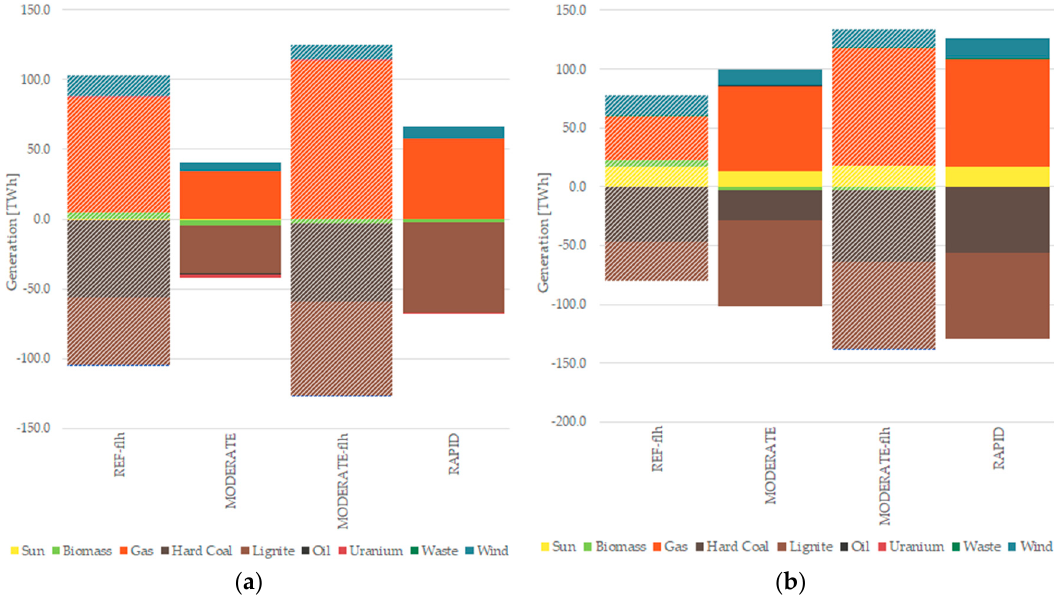
Figure 6. Shift in electricity generation across Europe in 2020 ( a ) and 2030 ( b ) as a result of a German coal-exit relative to the base case (own calculations). Energies 2020 , 13 , x FOR PEER REVIEW